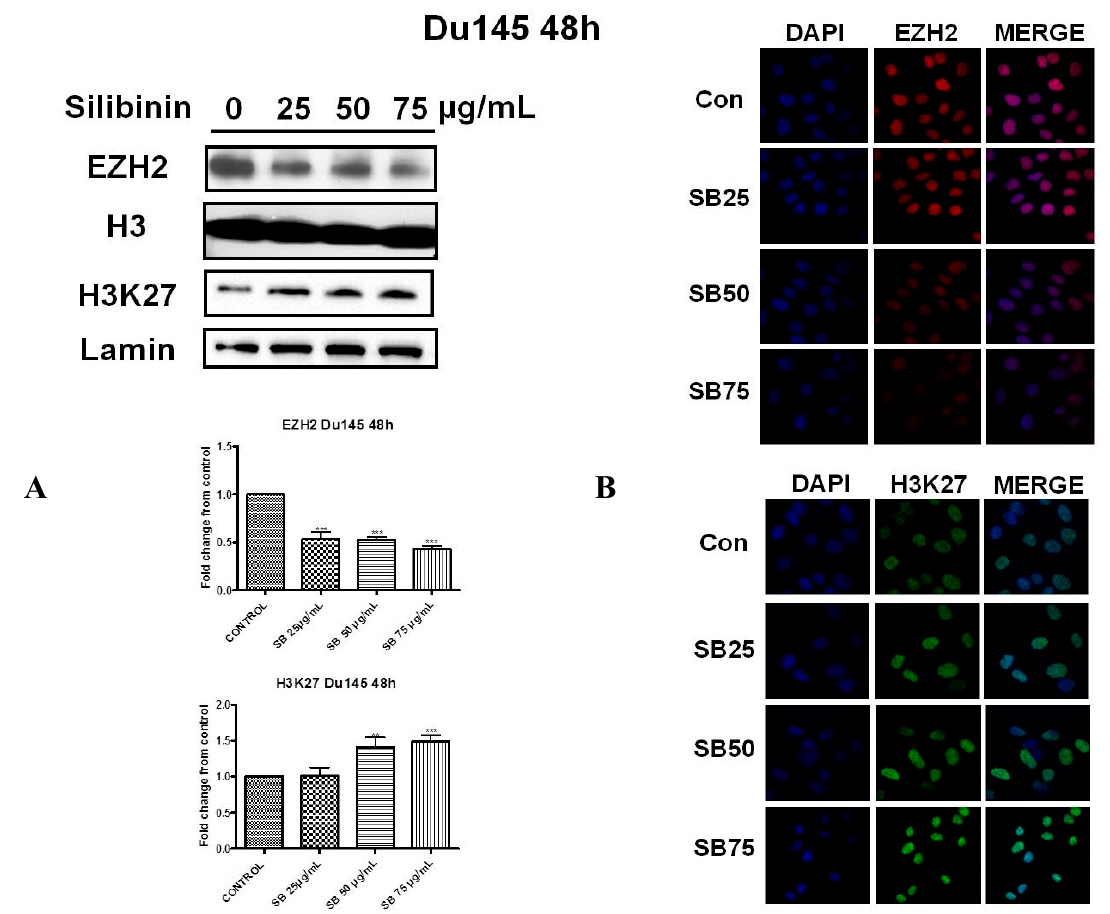
Figure 2. Silibinin reduces EZH2 expression while it increases trimethylation of Lys27 on H3 (H3K27me3). ( A ) DU145 cells were treated with different concentrations of silibinin (25–75 μ g/mL) for 48 h. Nuclear extracts were analyzed for EZH2 and H3K27me3 by western blotting. Representative blots are shown. Equal protein loading was verified by stripping and re-probing the same membranes with histone H3 and lamin- β (2A upper panel). Quantification of EZH2 and H3K27me3 bands was performed by scanning densitometry (2A lower panel). The results are presented as the mean ± SD of three or more independent experiments. ** p < 0.01; *** p < 0.001; ( B ) DU145 cells were grown on coverslips in 6-well chamber plates for 24 h prior to treatments with various concentrations of silibinin (25–75 μ g/mL) for 48 h. Cells were fixed and processed for staining with anti-EZH2 ( 2B upper panel ) and anti-H3K27me3 ( 2B lower panel ) antibodies, as described in ‘Materials and Methods’. Specific antibody staining was detected by fluorescein-conjugated secondary antibody and counterstained for DNA with 4 ′ ,6-diamidino-2-phenylindole (DAPI). The blue fluorescent staining column is for DAPI, the second red/green fluorescent column is for EZH2/H3K27me3 respectively, and the third column is for both images merged.